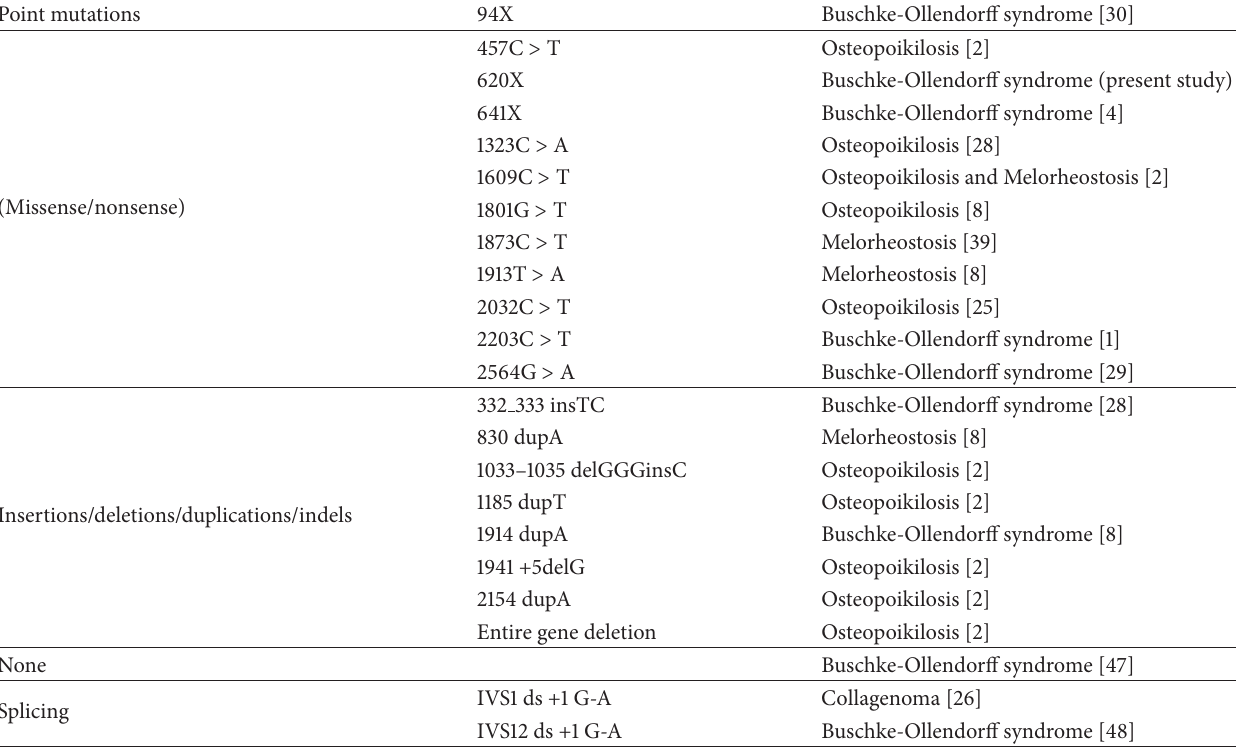
Table 1: Previously reported LEMD3 mutations.